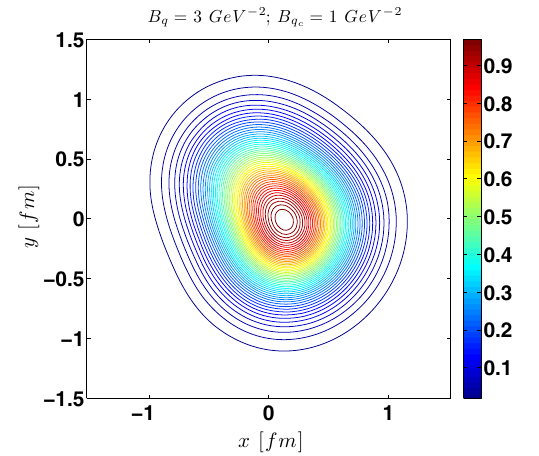
Fig. 4 Coherent and incoherent J /Ψ photoproduction cross section at (cid:4) W (cid:5) = 100 GeV. The full line show the results for the incoherent scattering and the lumpy configuration parameters of Fig. 3 ( B qc = 3 . 3 GeV − 2 , B q = 0 . 7 GeV − 2 ). The same parameters used for the coherent scattering give the result shown by the dashed line. For comparison also the coherent results obtained without geometric fluctuations ( B = B G = 4 GeV − 2 (dot-dashed line)) are shown. Coherent H1 data from Refs. [16,17] (circles), incoherent data (triangles) from H1 and ZEUS experiments of Refs. [17,18]. The single square refers to the total cross section of the H1 experiment at large momentum transfer [19]